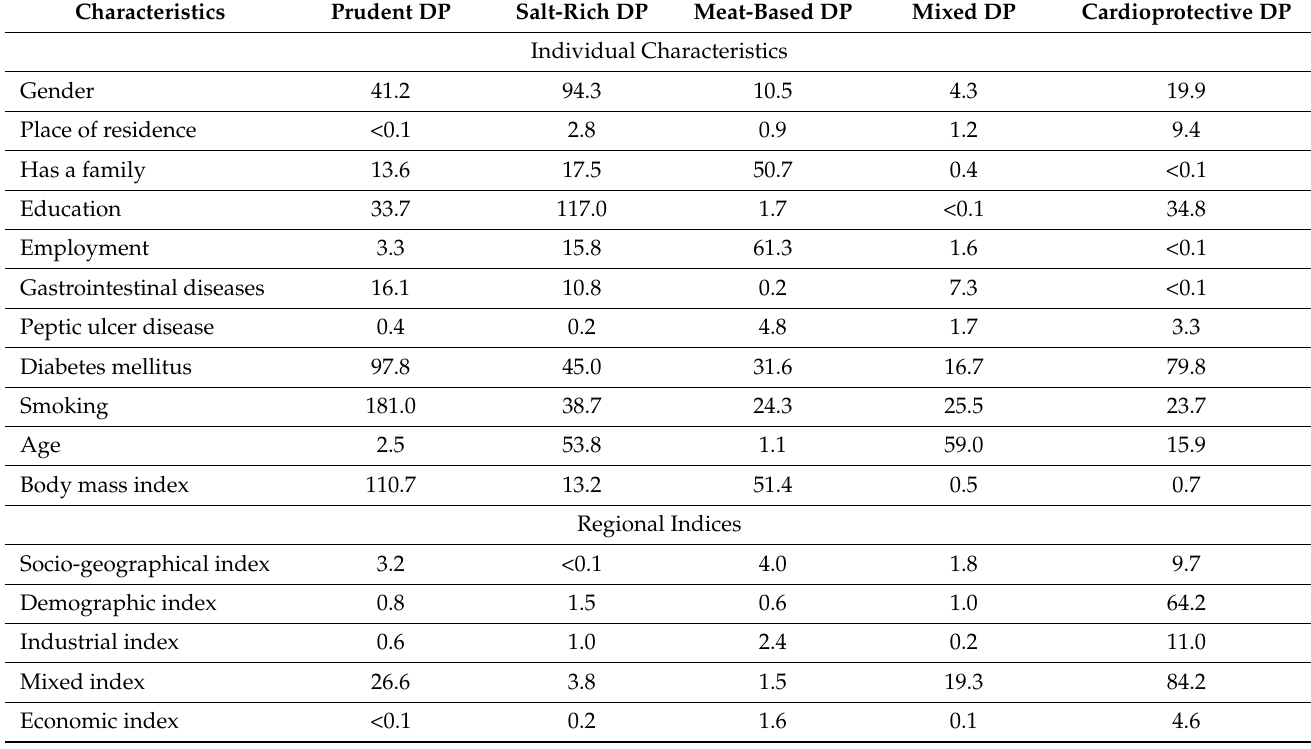
Table 3. The values of the model effect criteria (type III likelihood-ratio test, Wald chi-squared